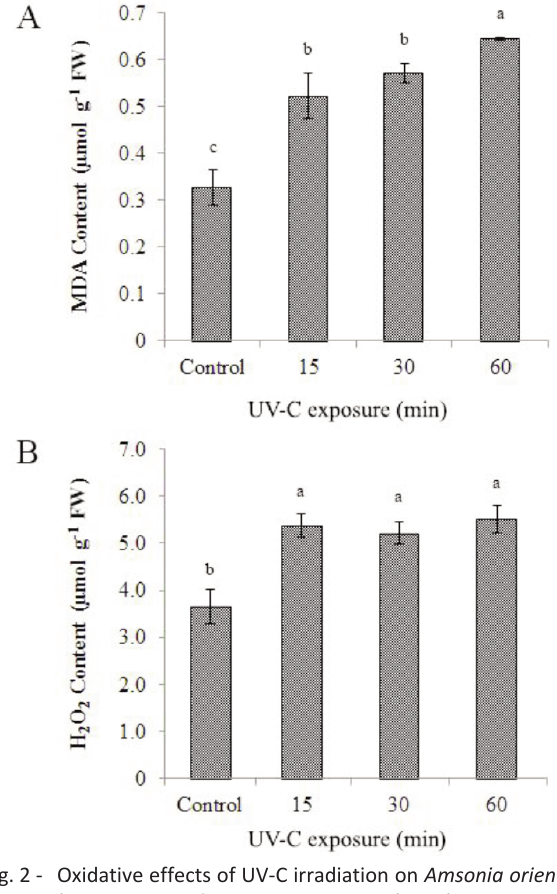
Fig. 2 - Oxidative effects of UV-C irradiation on Amsonia orienta- lis . A= MDA and B= H 2 O 2 contents. The values are repre- sented as means ± SD, different letters denote significant differences